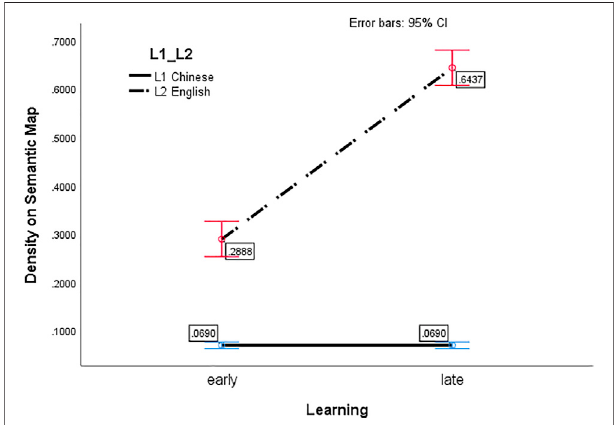
FIGURE 4 | A line graph of the average density levels of the L1 and L2 regions on the semantic map under the two learning conditions.